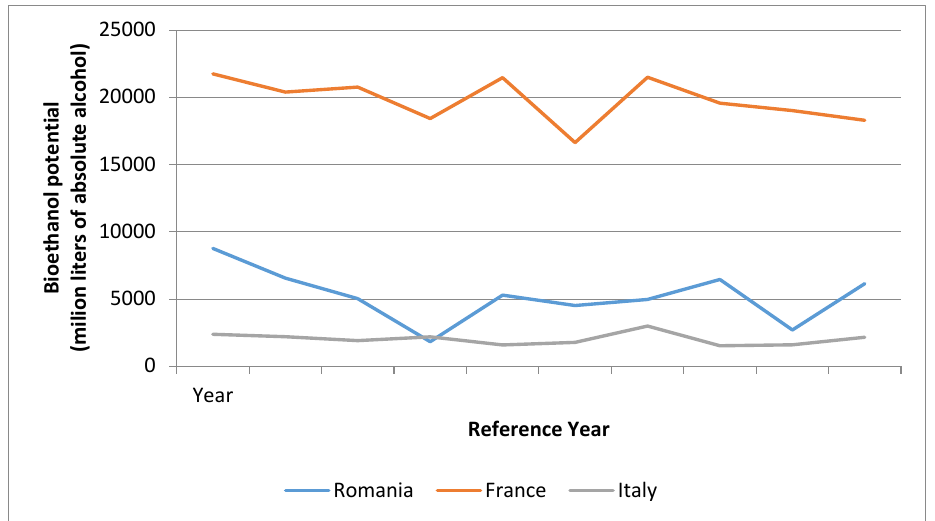
Figure 7. Bioethanol potential variation. Source: authors’ own computation based on [56]. For the biodiesel potential the annual variations (Figure 8) reach values of 524,000 tons for Romania, 119,000 tons for France and 12,000 tons for Italy.